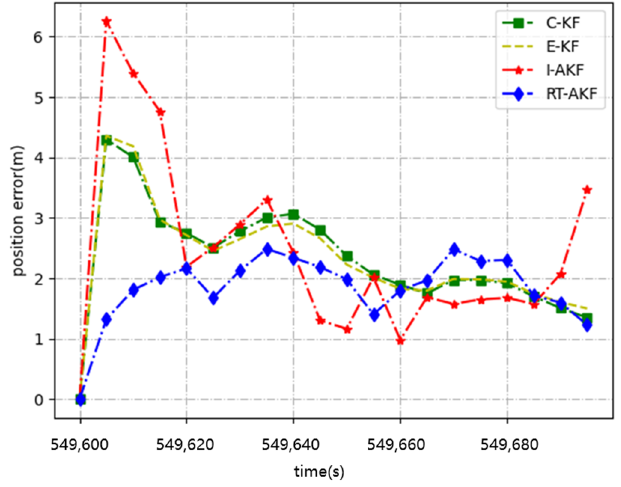
Figure 20. The positioning errors of GNSS/INS tightly coupled integrated by different methods in segment #7.